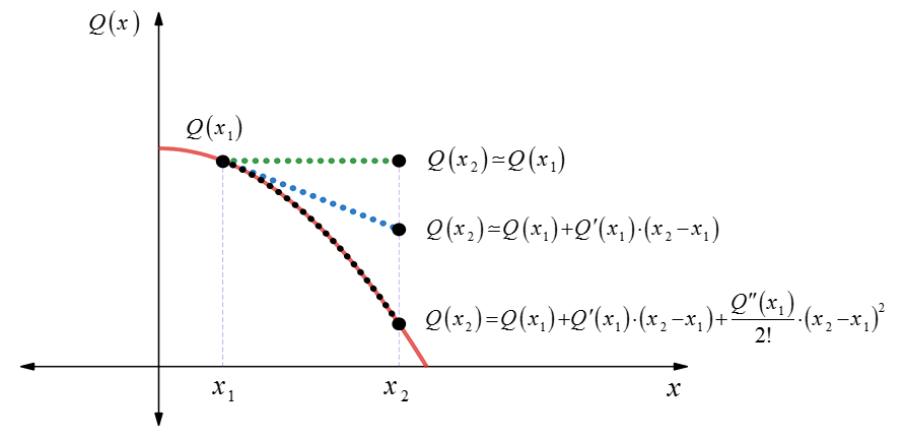
Figure 1. Second-order Taylor approximation around x 1 to obtain the exact value for a quadratic function at x 2 .